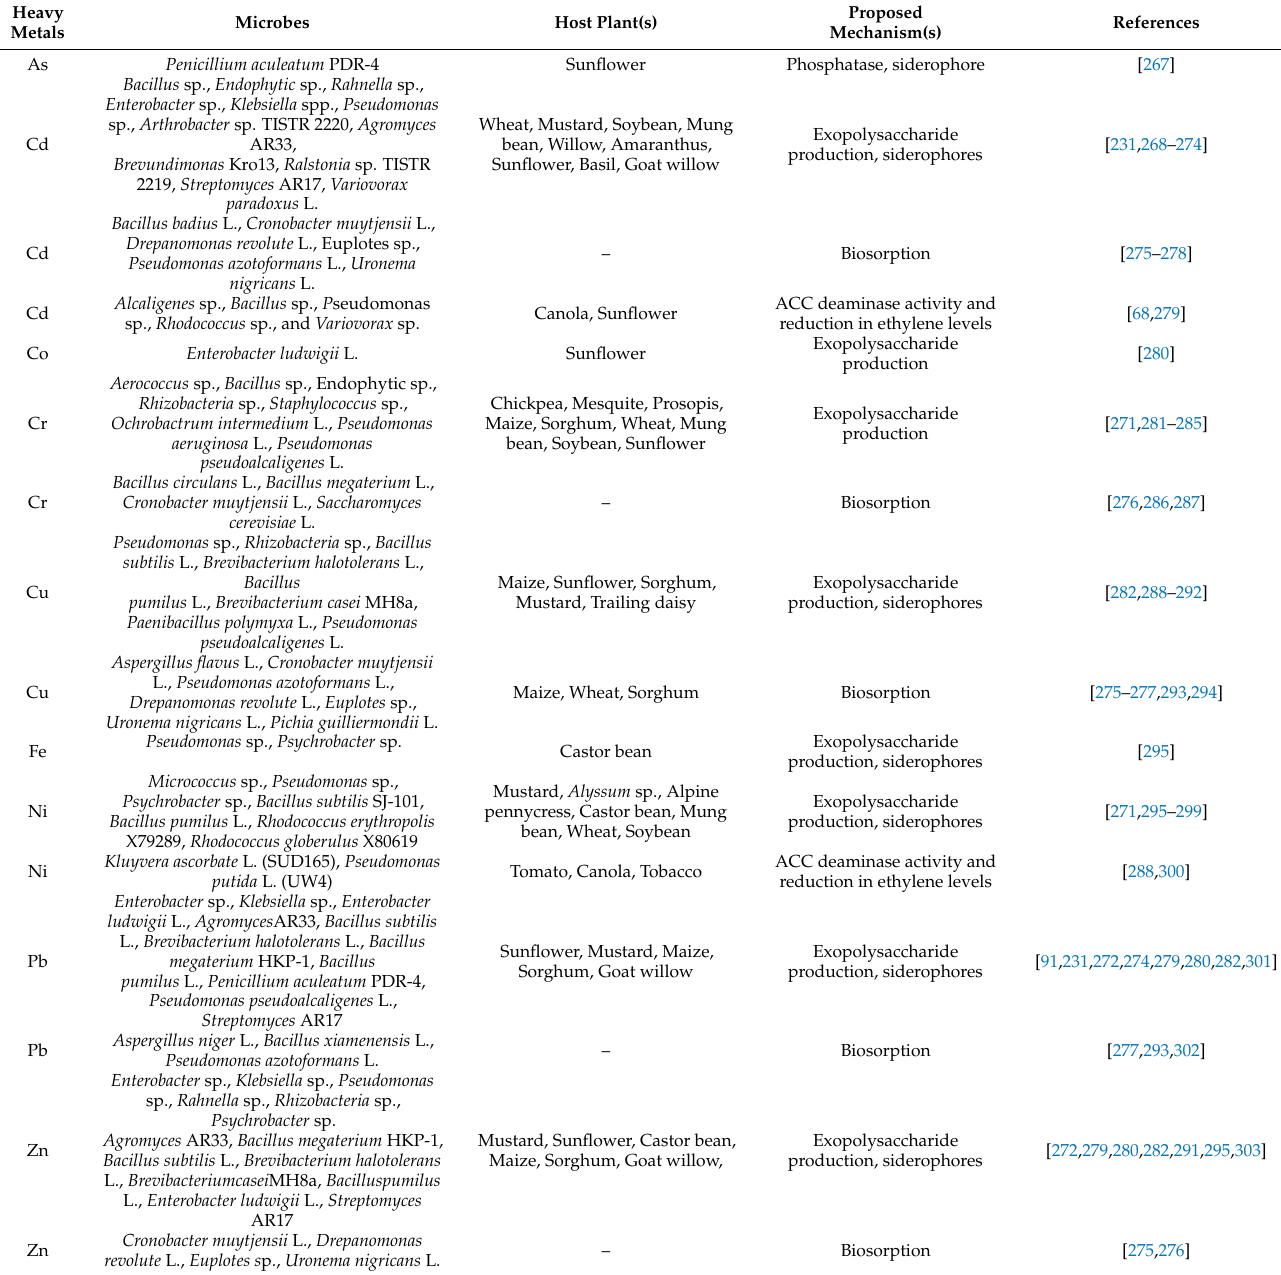
Table 4. Summary of studies on rhizobacterial mechanisms involved in the bioremediation of heavy metal-contaminated